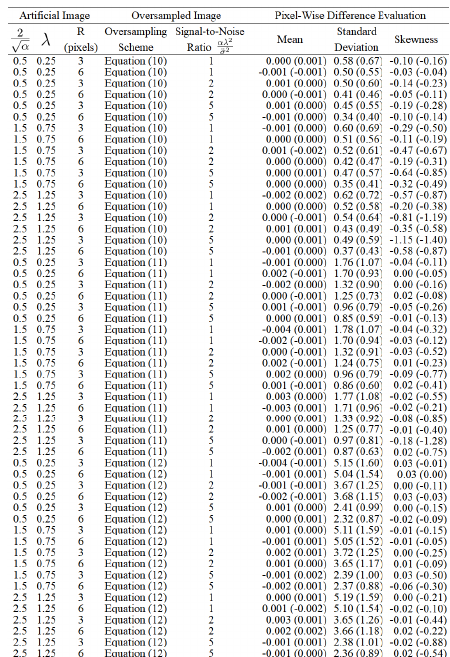
Table 1. The summary of the feasibility of the proposed method. The pixel-wise differences are obtained via subtracting the pixel values in the artificial images from the corresponding pixel values in the corresponding reconstructed images. Two, three, and four pixels from each side of the images are excluded from the pixel-wise-difference calculations when the size of the resampling matrix is three-by-three, five-by-five, and seven-by-seven, respectively. As a comparative base, the values in parentheses are the corresponding results when the elements in Equations (10), (11), and (12) are replaced by the values: 1 , 9 1 , and 1 , 25 49